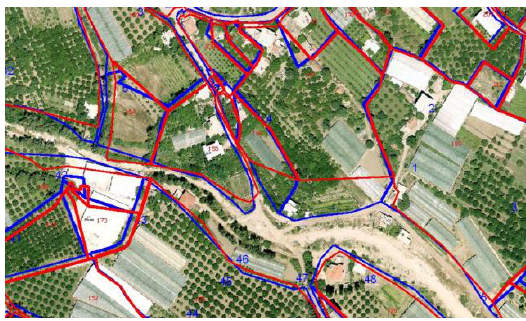
Figure 15. Purchase of land parcels created by digitization and the overlapping of the orthophoto Spatial digitization of cadastre and land registry information is also prepared for the integration of real estate System (MEGSİS) orthophoto services will be provided access to the system, the location and the quality of the integrated cadastral parcels are checked immediately (Figure 16).